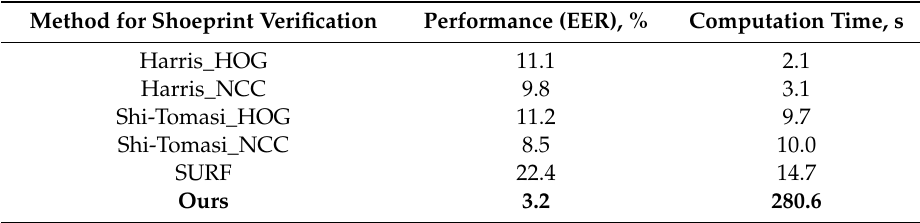
Table 2. Summary of the experiments in terms of shoeprint verification performance on the MUES-SV1KR2R dataset measured by the equal error rate (EER).